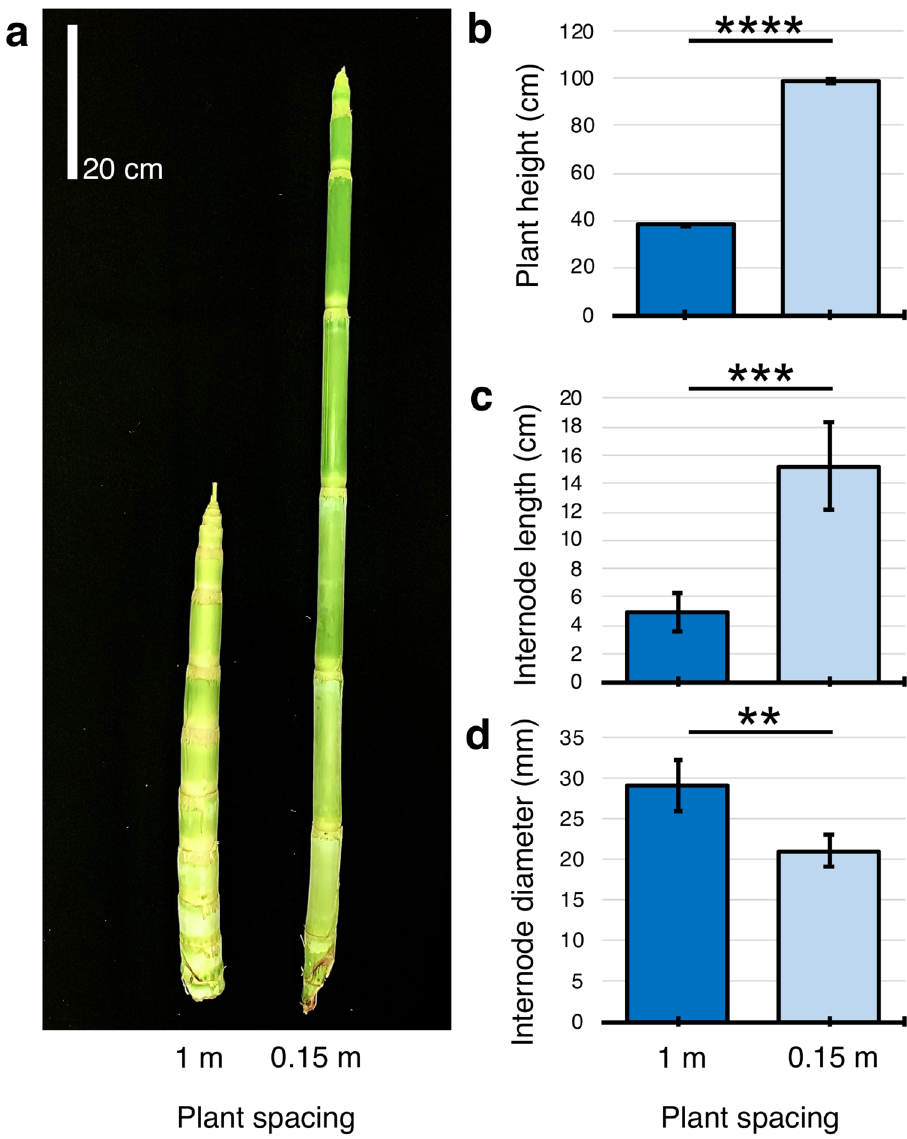
Figure 1. Plant spacing alters sorghum stem growth and morphology. ( a ) Photograph of stems of bioenergy sorghum plants grown for 60 days in the field at 1 m or 0.15 m spacing, ( b ) average height of plants grown at 1 m and 0.15 m spacing. Average length ( c ) and diameter ( d ) of elongated internodes of plants grown at 1 m or 0.15 m spacing. Asterisks indicate two-tailed P value; ****P < 0.0001, ***P = 0.0007, **P = 0.0019, by Welch’s t test (n = 5). Error bars: